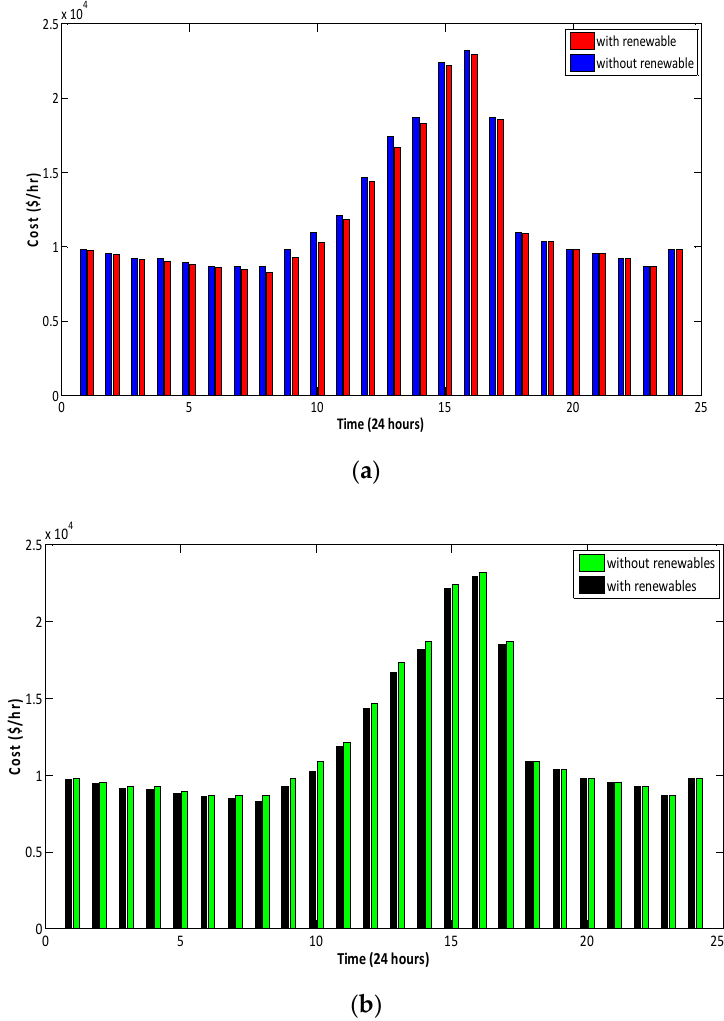
Figure 4. Cost offered by ( a ) BA and ( b ) dBA without and with considering renewables. Figure 4. Cost o ff ered by ( a ) BA and ( b ) dBA without and with considering